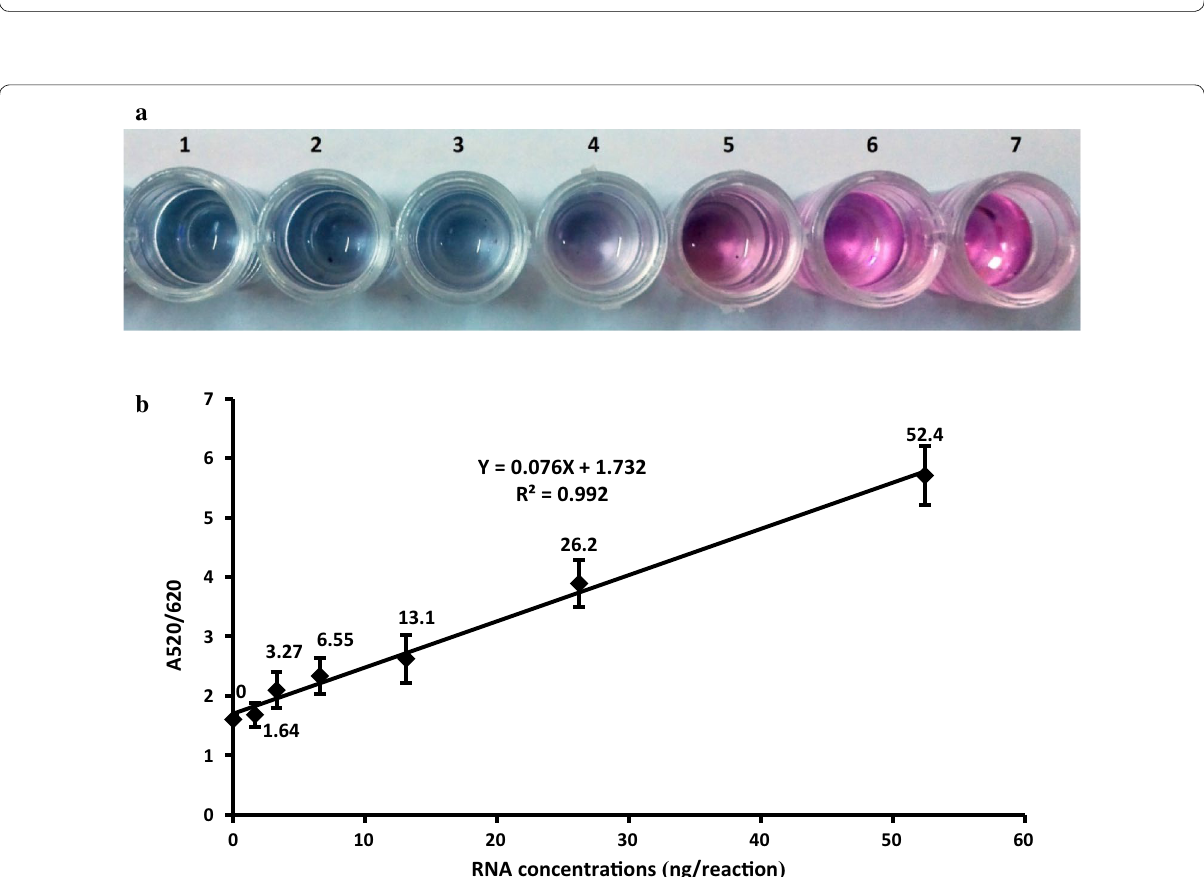
Fig. 4 a Visual color changes of developed detection assay at different BVDV-RNA concentrations. Wells 1 – 7 contain 0, 1.64, 3.27, 6.55, 13.1, 26.2, and 52.4 ng/reaction of RNA respectively. b Plot of linear correlation (R 2